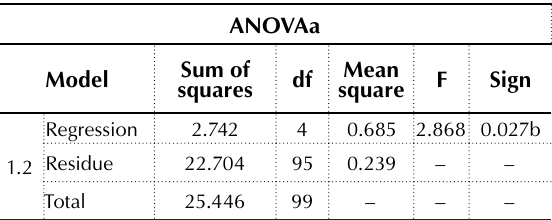
Table 7. ANOVA of model